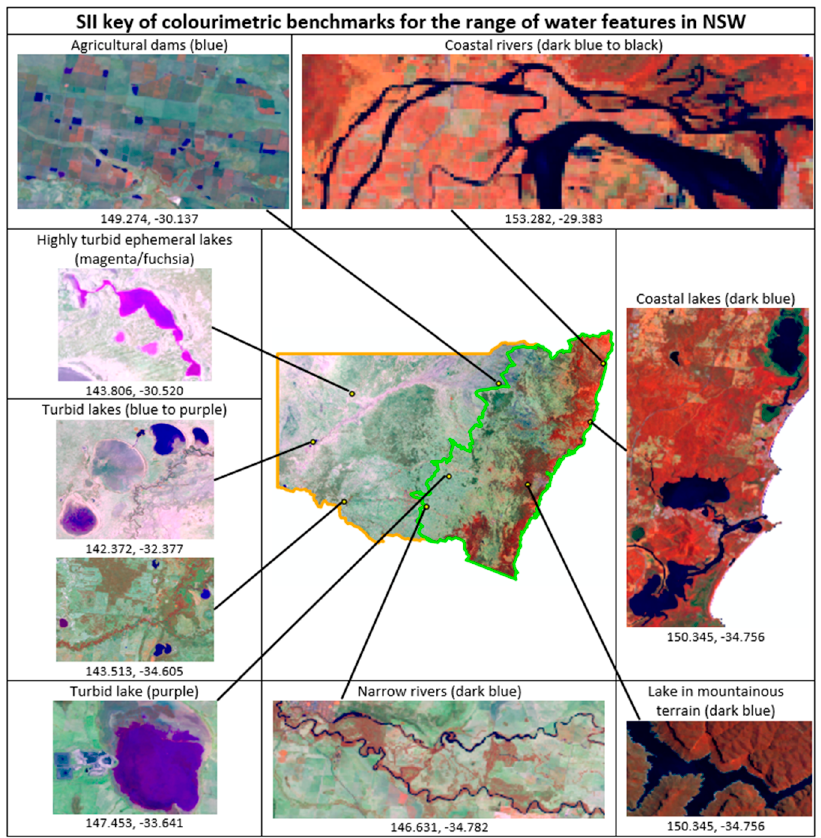
Figure 3. SII key colourimetric benchmarks for the variety of water features in NSW. Images viewed with a stretch of 2.5 standard deviations and a gamma of 1.5 in the ‘Land/Water’ RGB composite. All location co-ordinates are in decimal degrees.